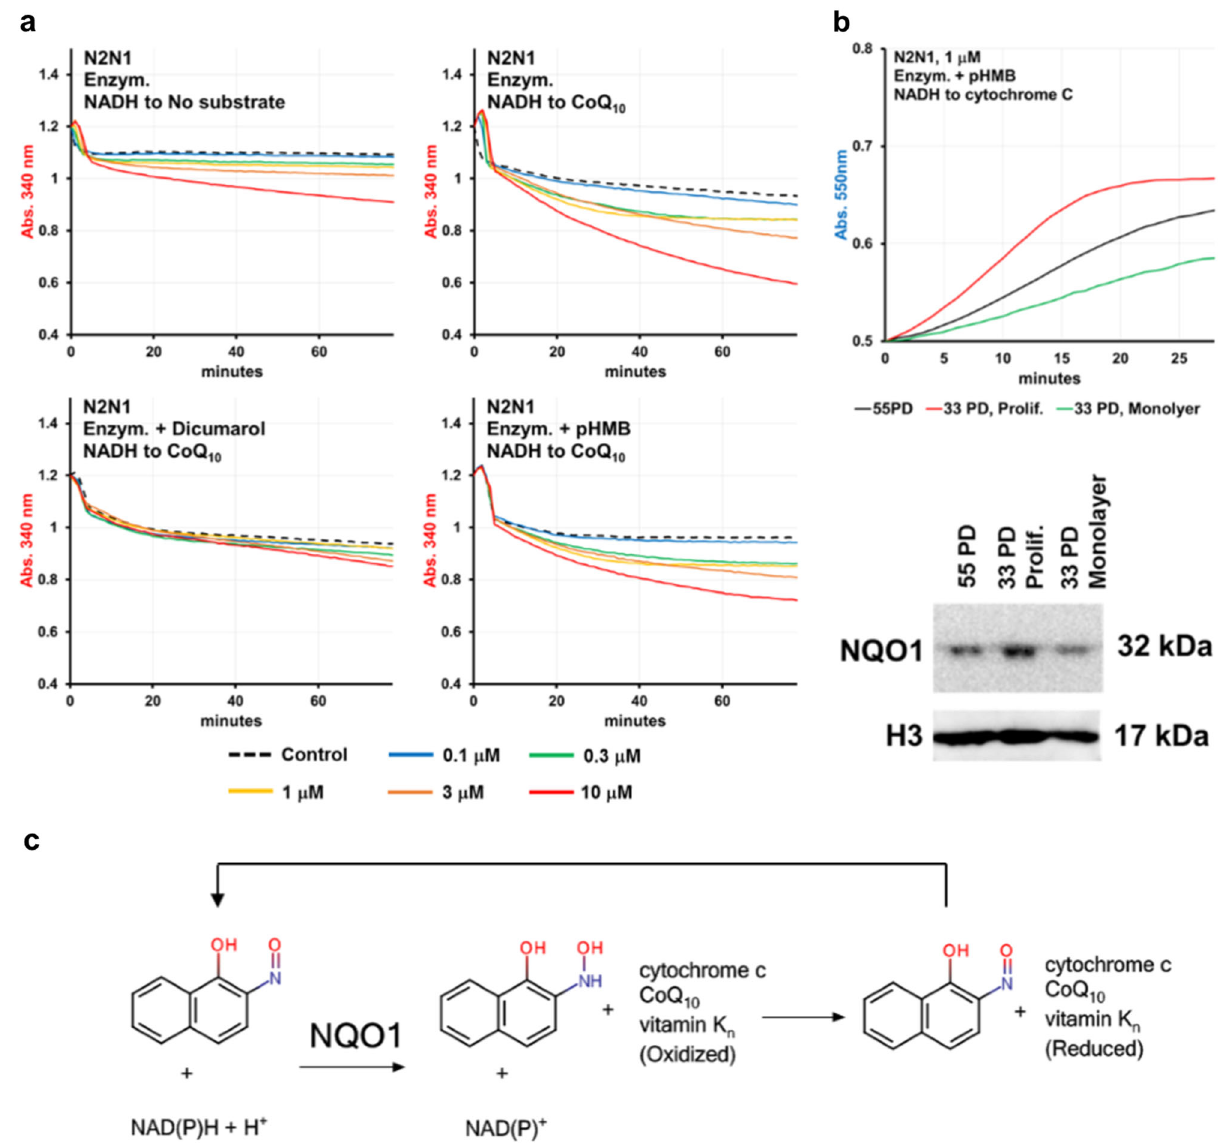
Fig. 6 Final evaluation of N2N1 mechanism of action as a partner of NQO1. a CoQ 10 can be used as a substrate in N2N1 assisted electron transfer from NADH. Reactions were supplemented with different concentrations of N2N1, pHMB or dicumarol. Rotenone was added to all reactions shown to inhibit mitochondrial Complex I activity. CoQ 10 reduction was monitored by decreases in absorption at 340 nm (NADH oxidation). Table S7a shows the reaction rates after addition of the inhibitors and control samples. b Analysis of NQO1 activity and expression level in NHDF at different replicative age (55 or 33 PD) and replicative status (33 PD at active proliferation or in monolayer). Table S6b shows the reaction rates for the shown plots. Western blots were derived from the same experiment and were processed in parallel. c